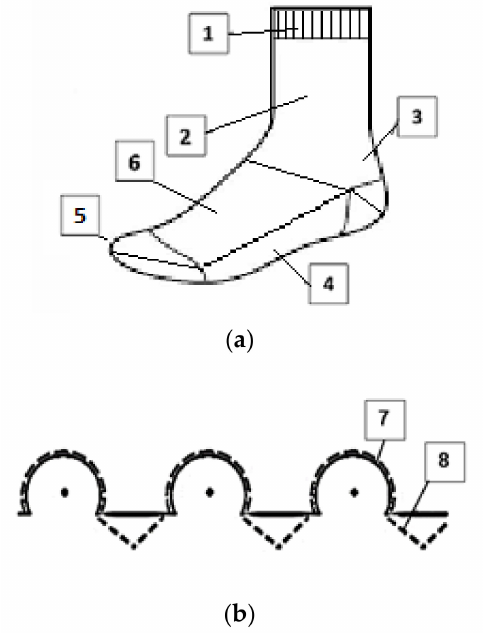
Figure 1. The main parts of the socks ( a ) and the spreading scheme of the of the yarns ( b ). Socks of 5 structures were manufactured on the single-cylinder sock knitting machine Fantasia (Sangiacomo S.p.A., Brescia, Italy) of gauge 14E (diameter of the cylinder,